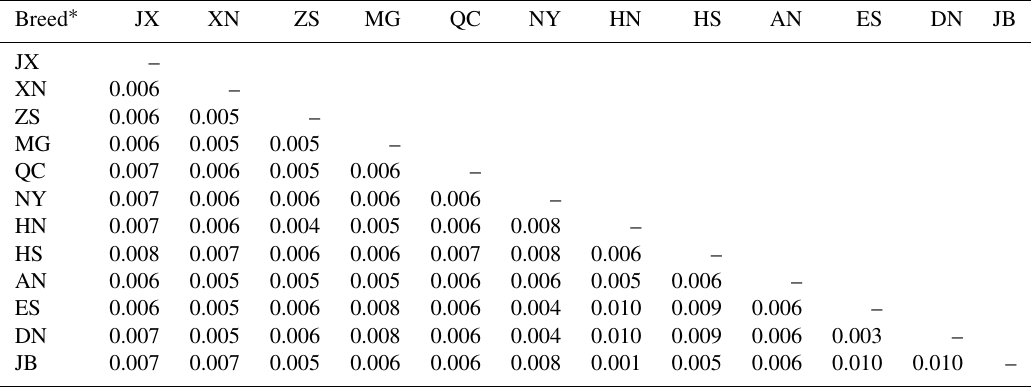
Table 4. Genetic distances among 12 cattle breeds based on mtDNA 16S rRNA gene sequences. Breed ∗